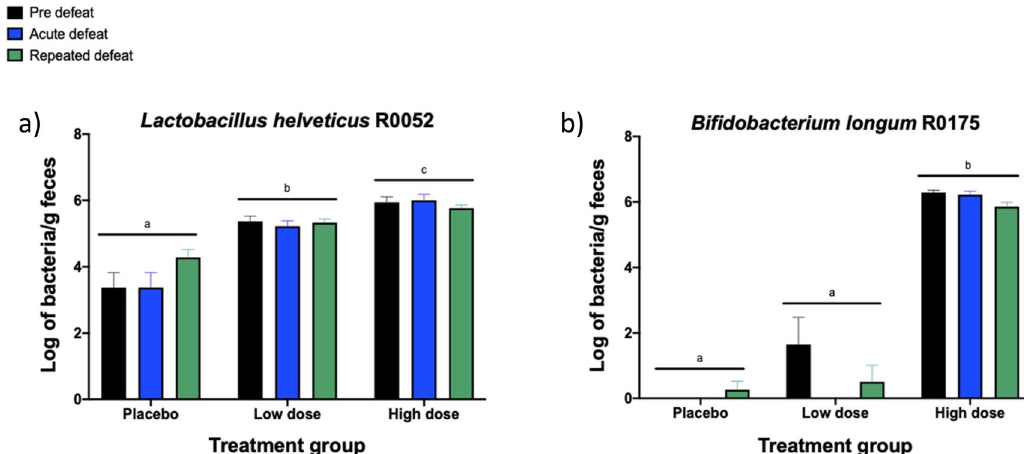
Figure 2. Probiotic intervention modestly alters the concentration of probiotic strains in feces. Concentrations of Lactobacillus helveticus R0052 ( a ) and Bifidobacterium longum R0175 ( b ) detected in fecal samples collected approximately 1 h before the acute defeat (pre defeat, black bar), 24 h following the acute defeat (blue bar), or 24 h following repeated defeats (green bar). Data are presented as mean +/− standard error of the mean; non- shared letters within each panel denote a significant difference ( p < 0.03).